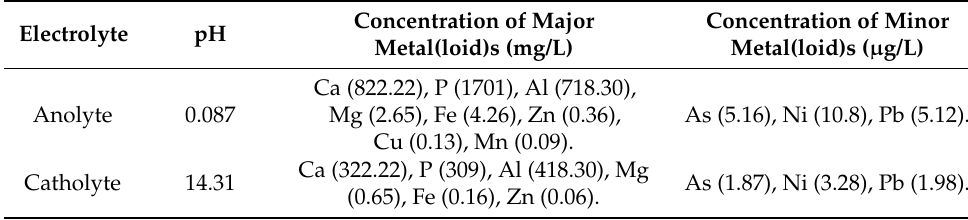
Table 4. Contents of anolyte and catholyte after the EDR process (50 mA, 14 days).